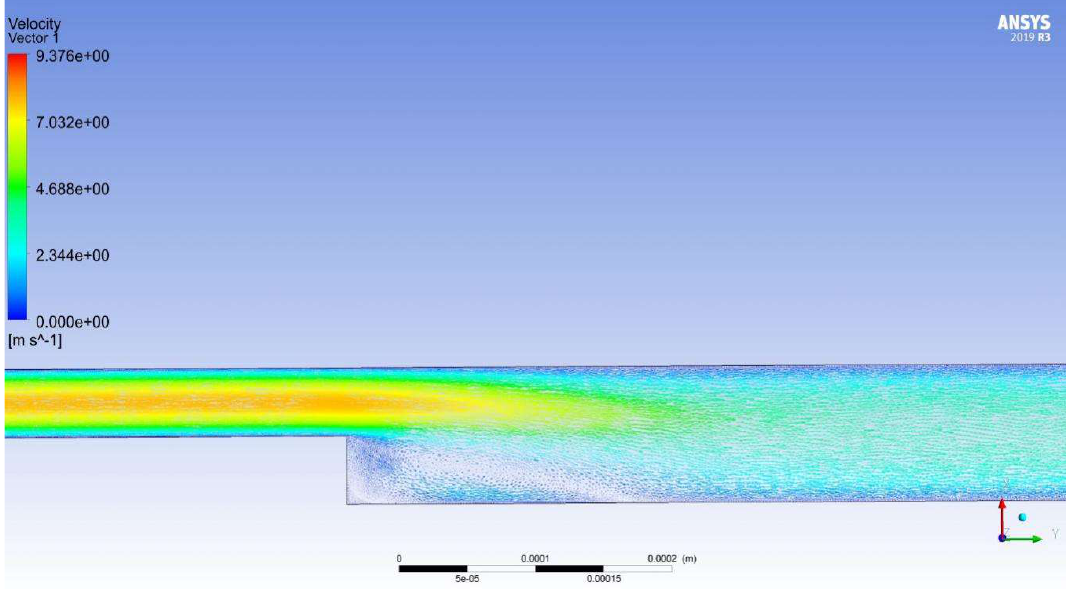
Figure 16. Velocity distribution in the turbulence model Standard k-epsilon.